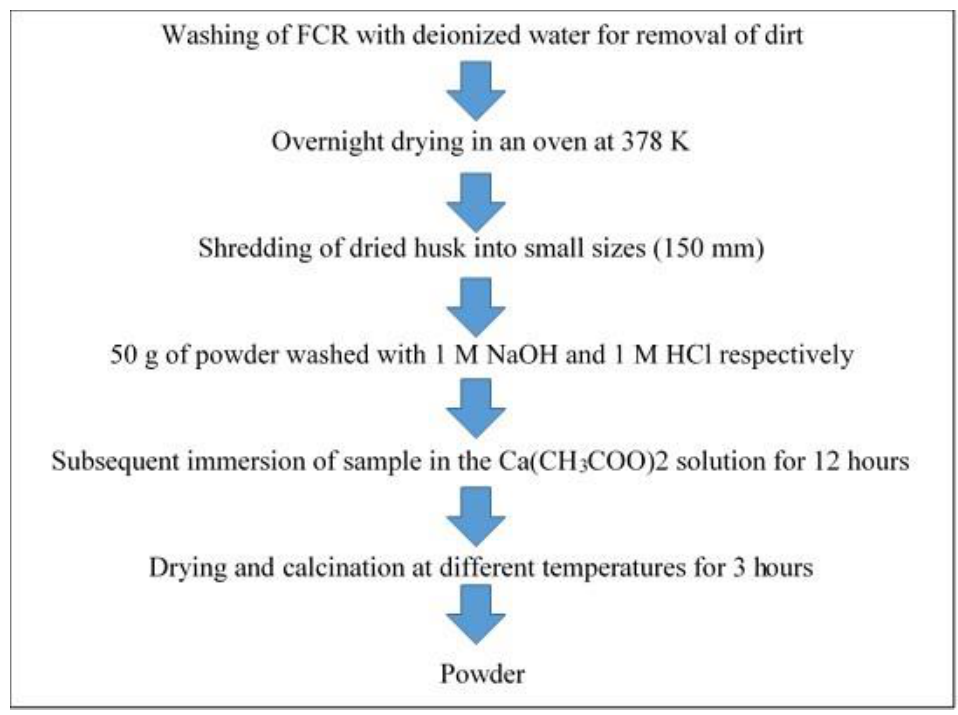
Figure 9. Steps involved in the synthesis of calcium carbonate nanoparticles from finger citron residue.